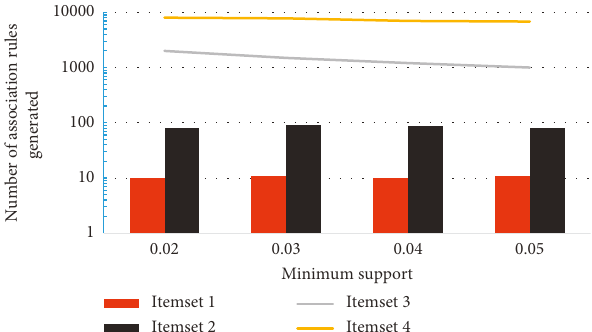
Figure 7: The change trend of the number of association rules generated by CIIC with the number of